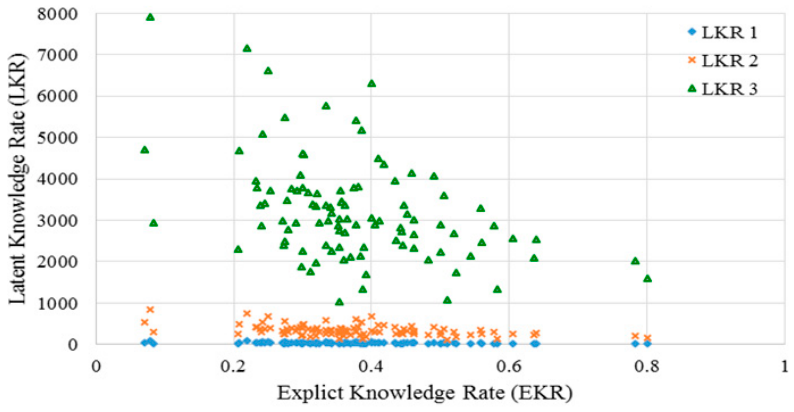
Figure 5. Change in latent knowledge rates ( m = 1, 2, 3) over explicit knowledge rate.